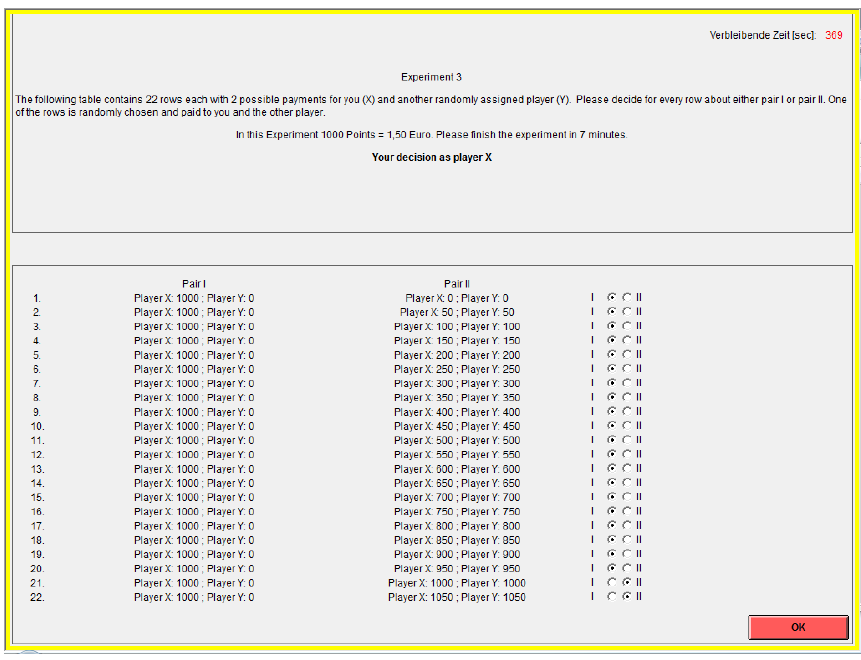
Figure A1. Z-Tree Screenshot of Elicitation of Unfavored Inequality Aversion. Notes: Players have to decide upon one of each column in every row. The procedure is as proposed by Danneberg et al. 2007.